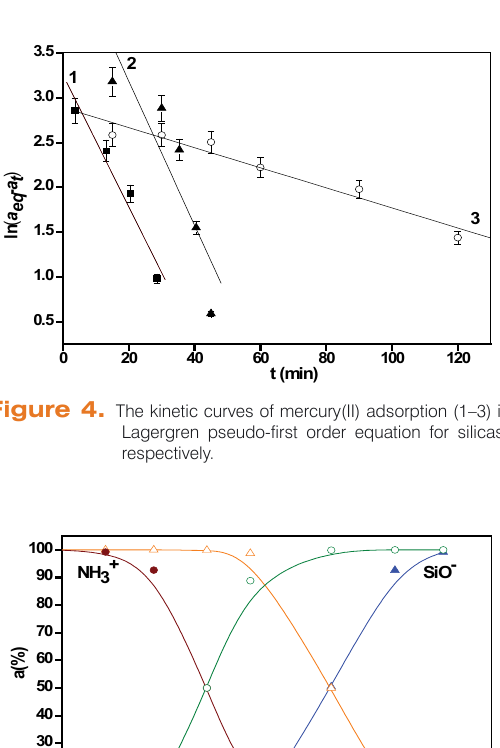
*Numbering of adsorbents correspond to Table 2